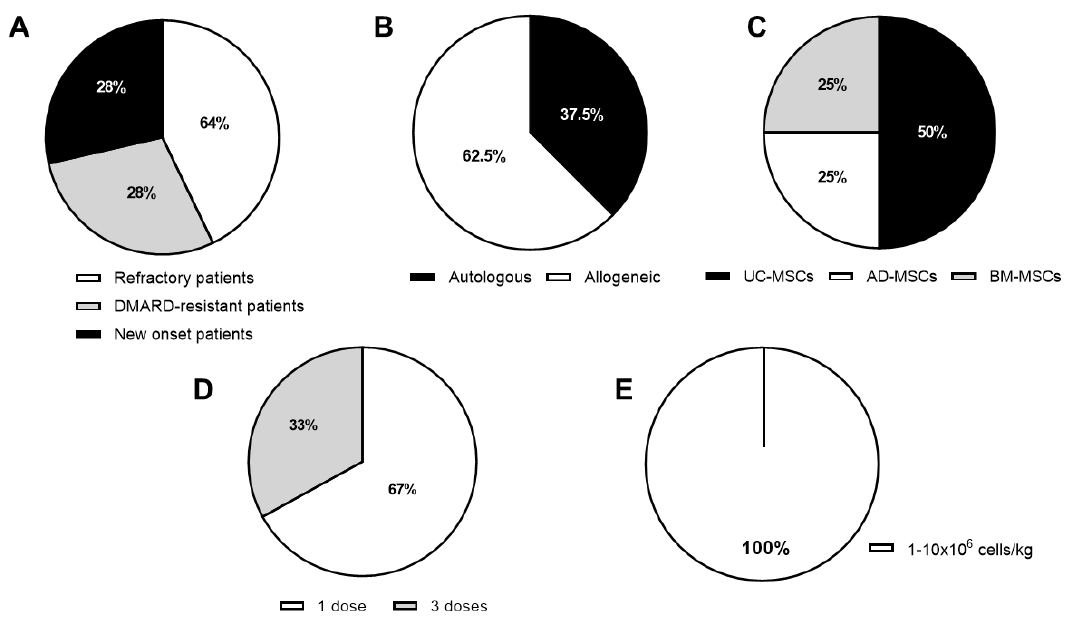
Figure 2. Characteristics of the open RA clinical trials. ( A ) RA disease status of patients; ( B ) MHC context ( C ) MSC tissue source. Umbilical cord (UC-MSCs), adipose tissue (AD-MSCs) and bone marrow (BM-MSCs); ( D ) number of MSCs infusions and ( E ) MSC dose expressed as number of cells/kg of body weight (1–10 × 10 6 ). Data are represented as percentage of the total number of studies.